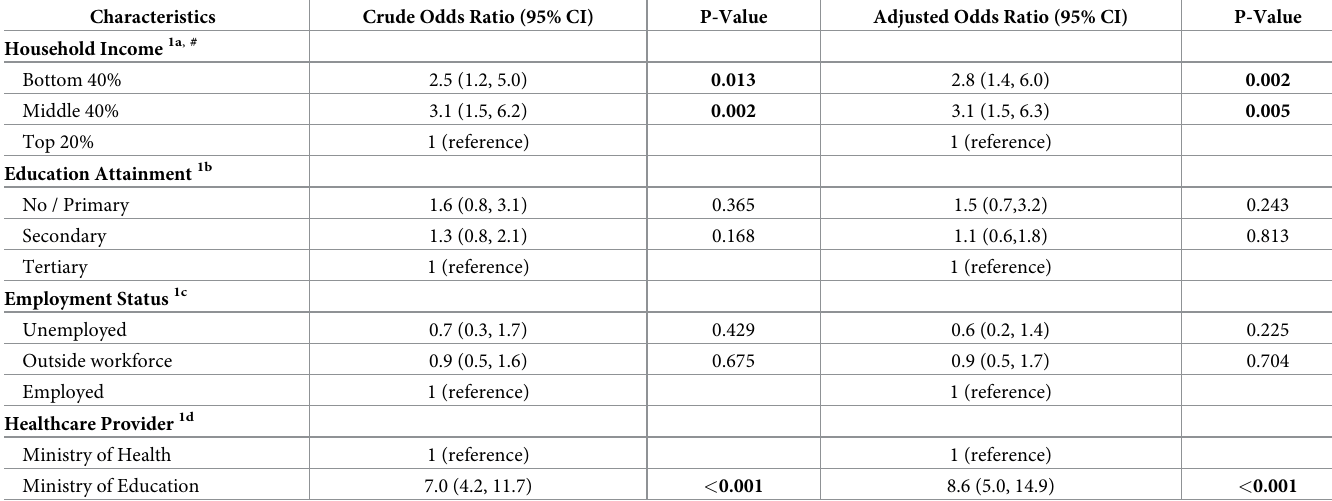
Table 4. Association between levels of socioeconomic status, healthcare provider and prevalence of catastrophic health expenditure.